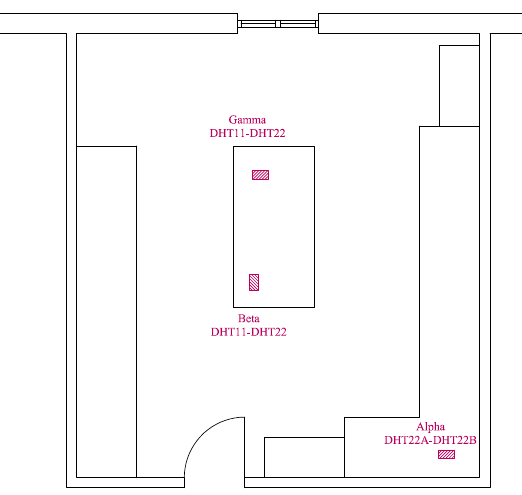
Figure 7. Laboratory floor map and devices